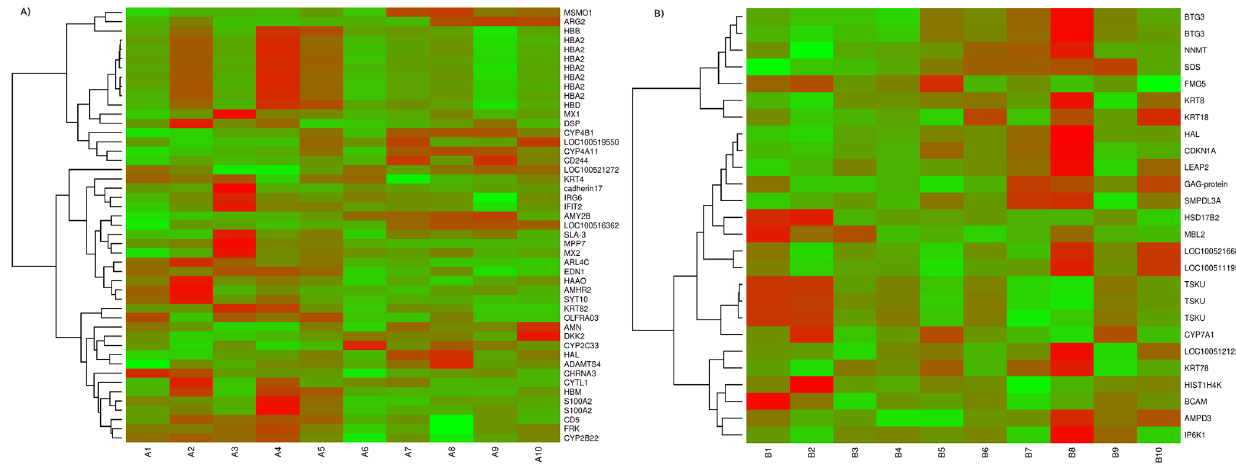
Figure 1. Heatmap showing differentially expressed genes in (A) testis and (B) liver samples. The red blocks represent over expressed genes, and the green blocks represent under expressed genes. Legend: A1–A5 testis with low androstenone and A6–A10 testis with high androstenone, B1–B5 liver with low androstenone and B6–B10 liver with high androstenone.